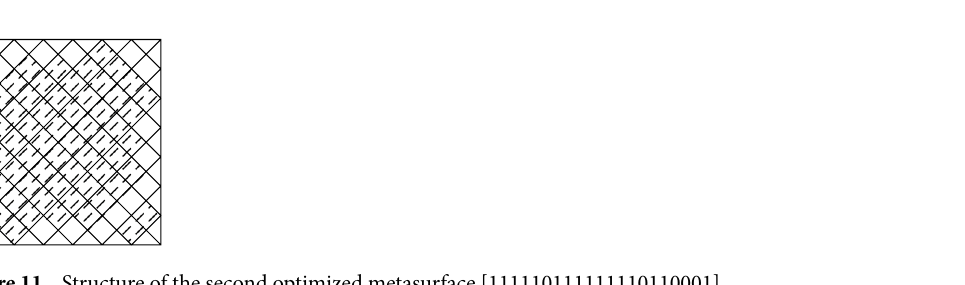
Figure 11. Structure of the second optimized metasurface